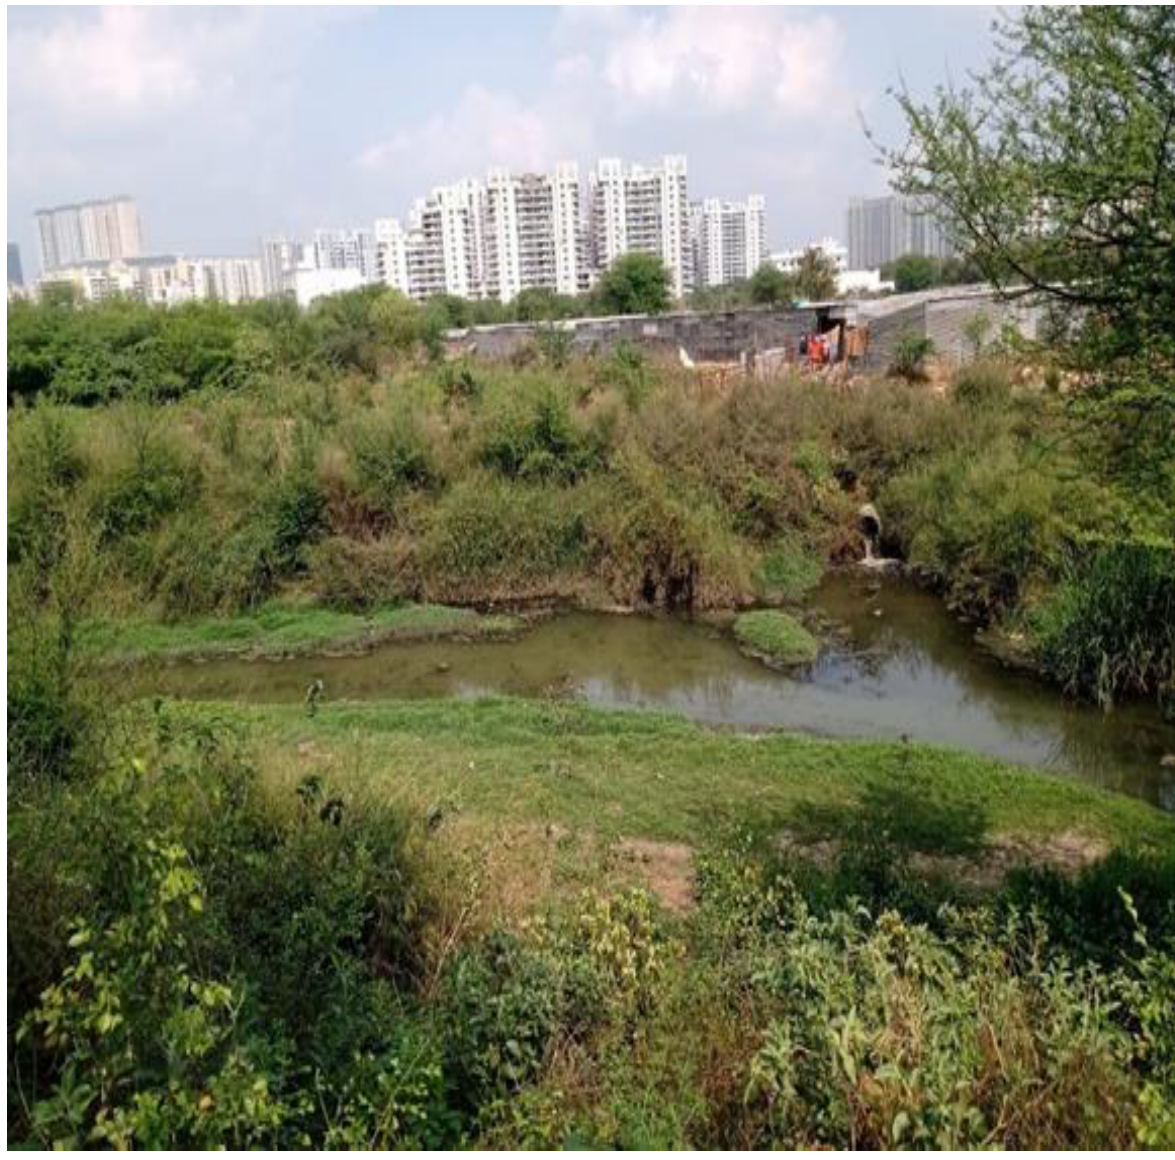
Figure 7. Fragmented blue-green elements in Gurugram (Field Survey, 2021).